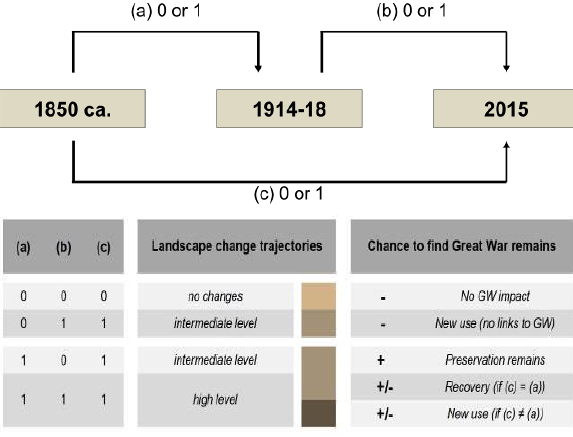
Figure 10 . Trajectories of landscape’s change: outline